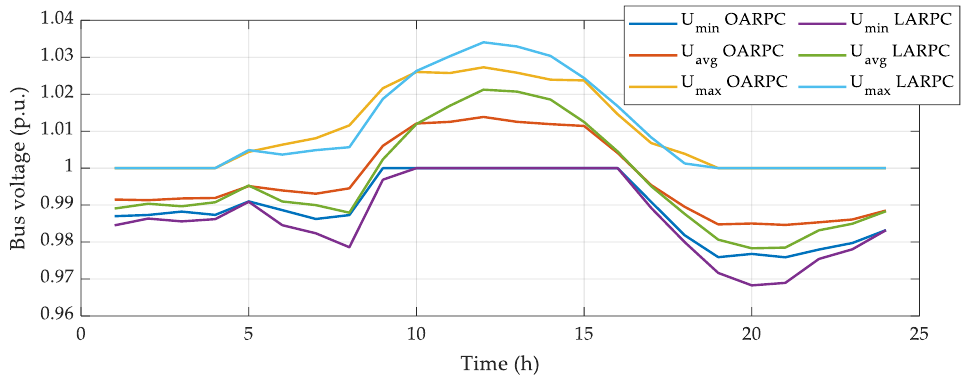
Figure 12. Hourly minimum, average and maximum voltage profiles comparison between OARPC and LARPC.